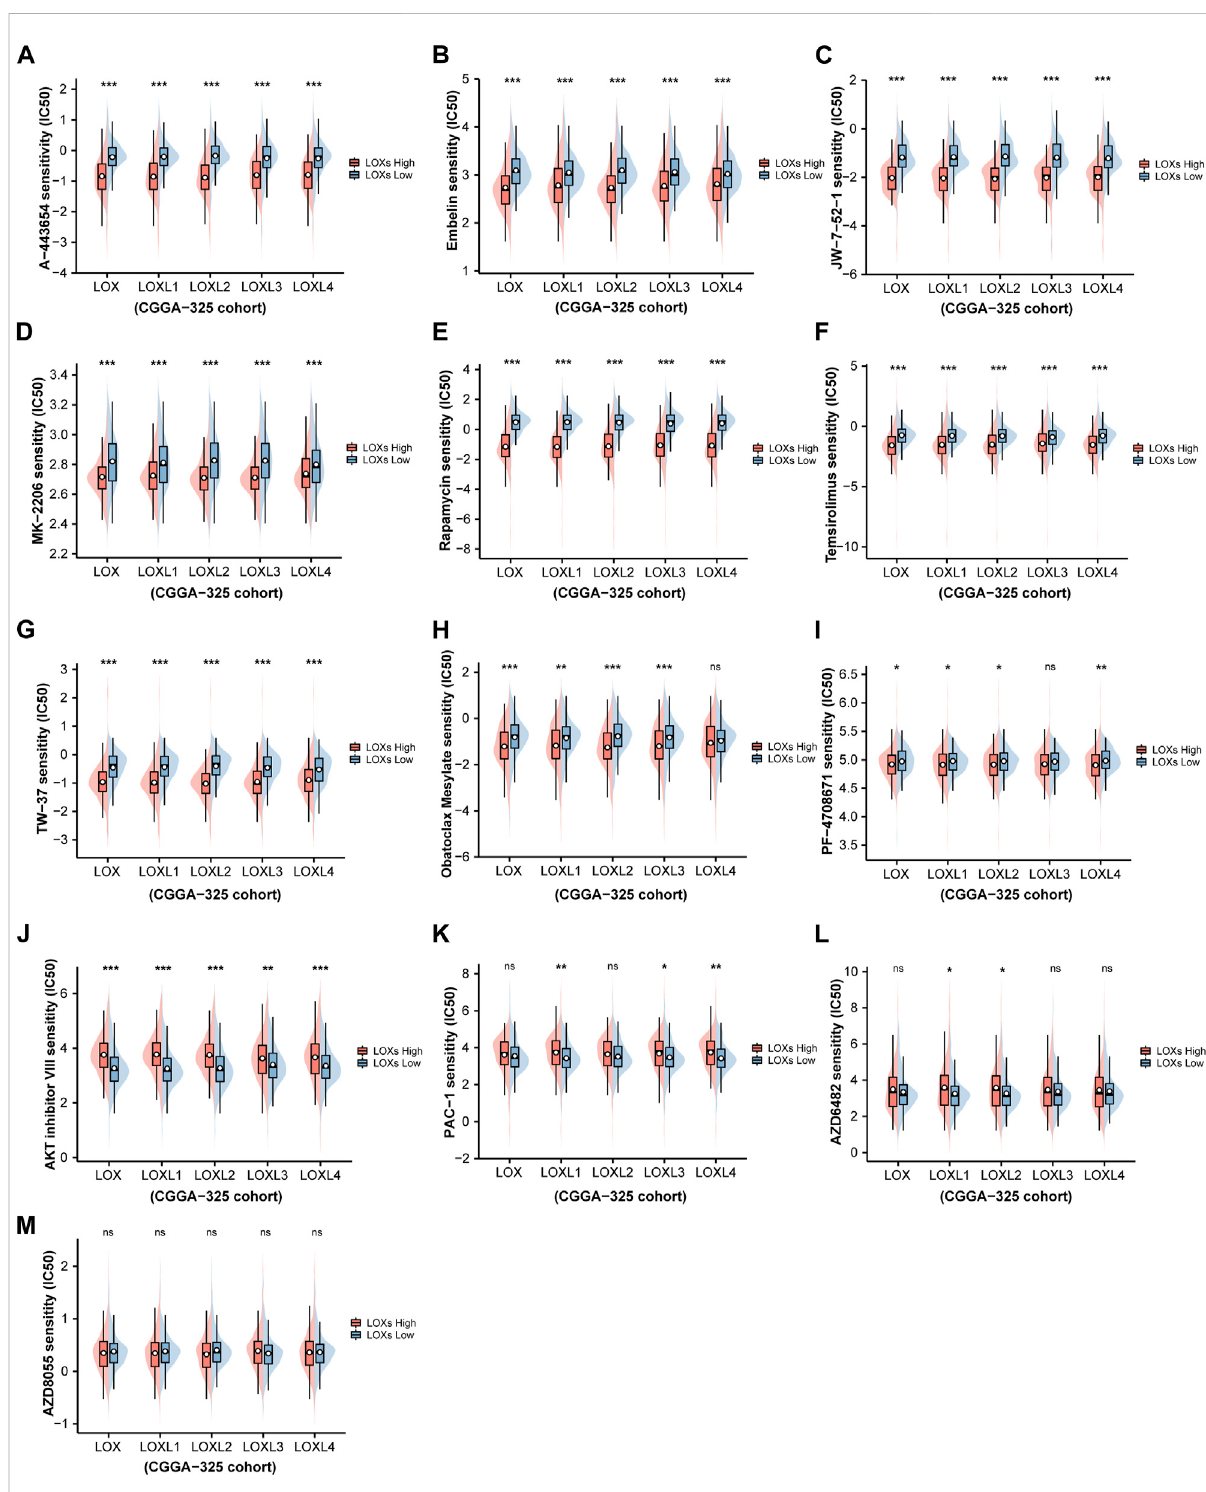
FIGURE 7 Predictionofchemotherapeuticdrugsensitivityinglioma via distinctLOXsexpressionsinCGGA-325cohort. (A – I) ShowstheestimatedIC50of nine drugs including A-443654, Embelin, JW-7-52-1, MK-2206, Rapamycin, Temsirolimus, TW-37, Obatoclax mesylate, and PF-4708671 are lower in the high-LOXs expression group compared with low-LOXs expression group; (J – L) indicates three drugs including AKT inhibitor VIII, PAC-1, and AZD6482 exhibits higher IC50 in the group with high levels of LOXs expressions; (M) no signi fi cant difference are observed in the IC50 value of AZD8055 between high-LOXs expression and low-LOXs expression